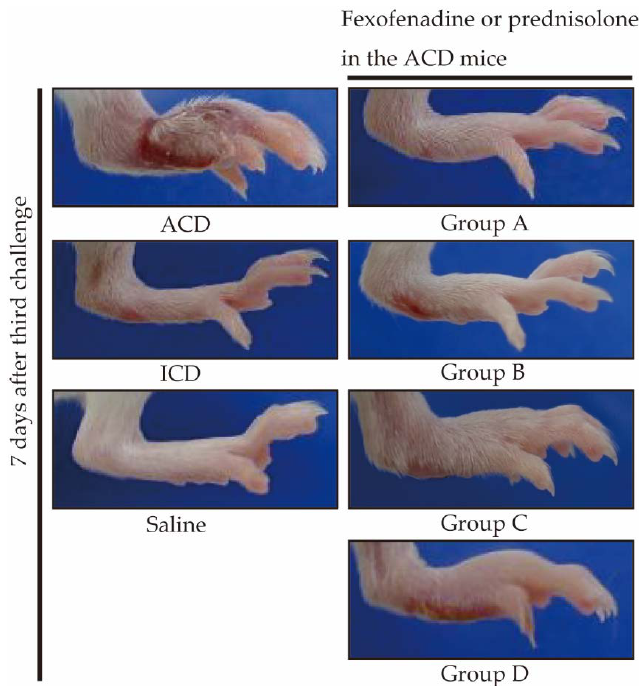
Figure 3. Macroscopic findings in Pd-induced ACD mice administered fexofenadine or prednisolone. Photographs show footpad swelling of a representative mouse at 7 days after the last challenge of Pd. In comparison with the footpad of Pd allergy mice, in terms of the redness and swelling, the feet of the groups A, B, C, and D showed decreases; in particular groups A and B showed dominant decreases.